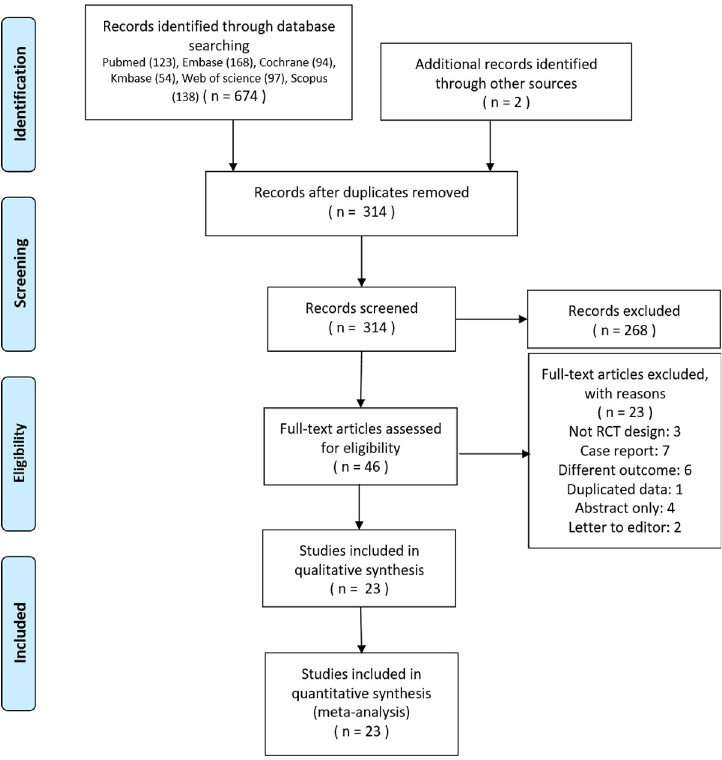
Fig 1. PRISMA flow diagram. A total of 23 randomized controlled trials of double-lumen tube intubation with videoscopes were included in this network meta-analysis.